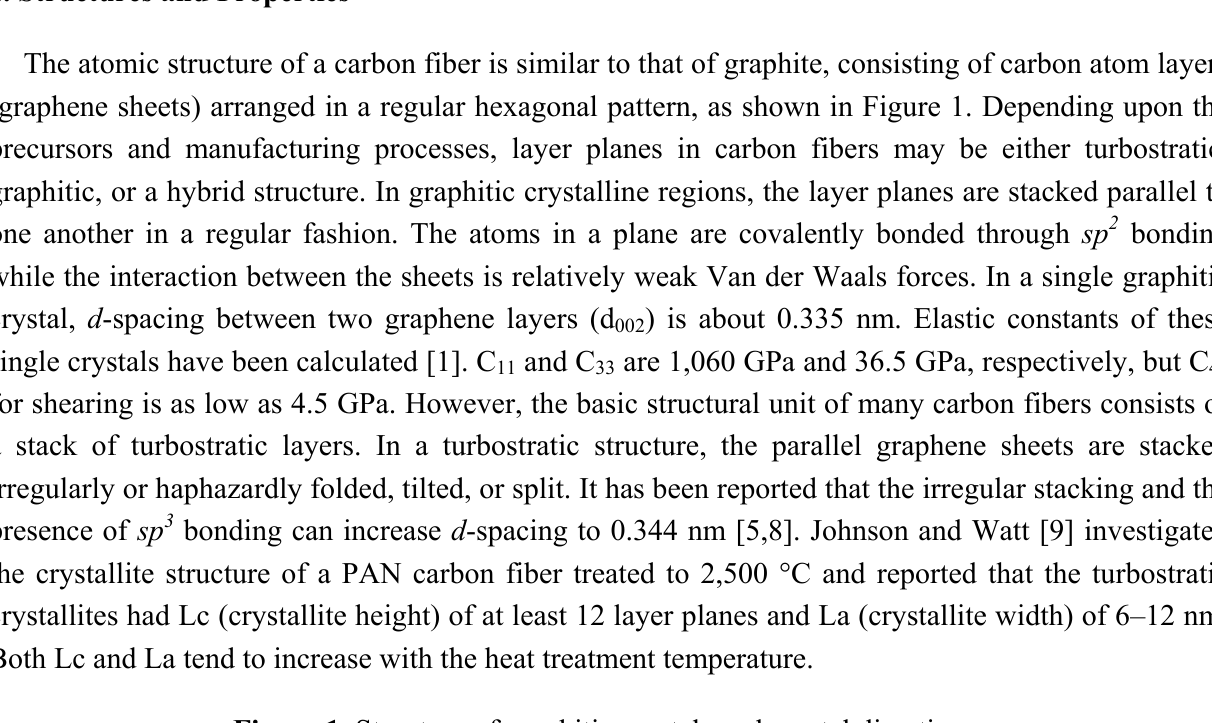
Figure 1. Structure of graphitic crystals and crystal